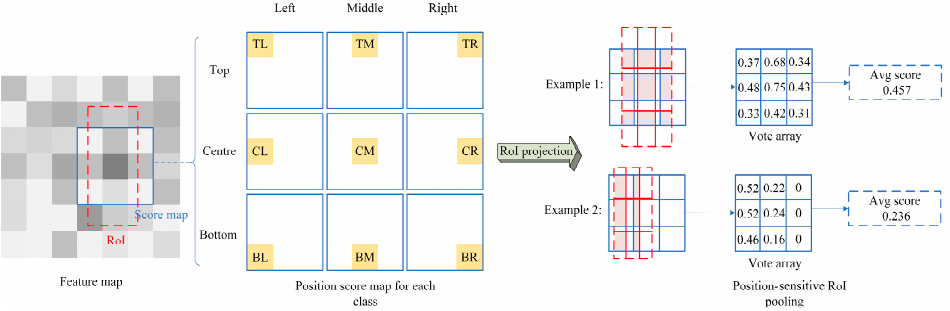
Figure 4. Illustration of the position-sensitive region-of-interest (RoI) pooling.